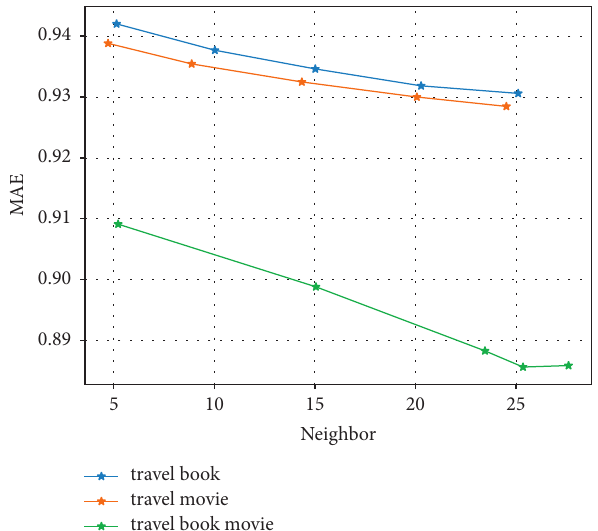
Figure 9: Performance of the algorithm in this paper with the same data